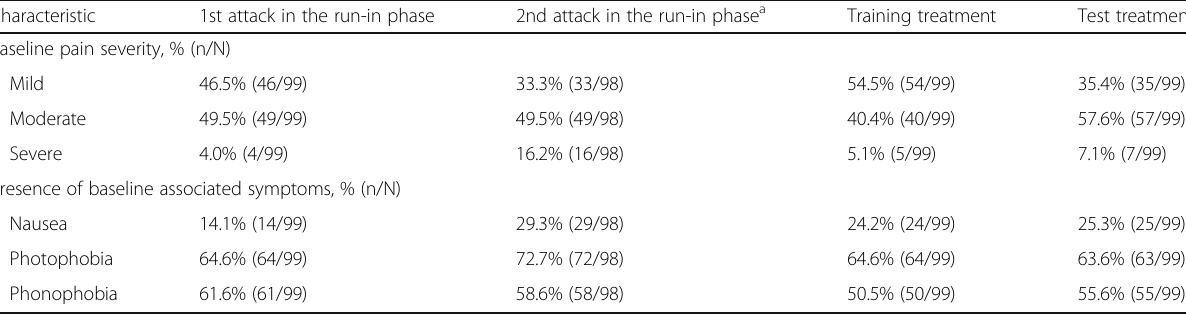
Table 1 Baseline characteristics of the treated attacks